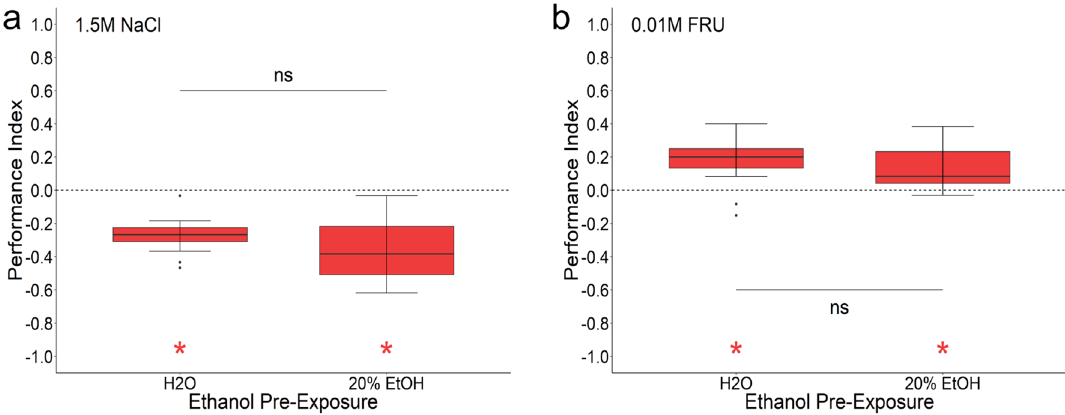
Figure 6. Pre-exposure to ethanol does not change aversive and appetitive olfactory learning. Before the larvae were conditioned, they were separated from their food and treated for 20 min with either water or 20% ethanol. They were then washed and trained with the odors AM and BA and either 1.5 M NaCl or 0.01 M fructose as a teaching signal. ( a ) Larvae treated with water and 20% ethanol both showed an aversive odor-salt memory (one- sample t test, pwater < 0.001, ppre-EtOH < 0.001) that was not different from each other (paired t-test, p < 0.112). Sample size for each box plot is n = 15. ( b ) Larvae treated with water and 20% ethanol both showed an appetitive odor-fructose memory (one-sample t test, pwater < 0.001, ppre-EtOH < 0.001) that was not different from each other (paired t-test, p < 0.484). Sample size for each box plot is n = 15. Differences against zero are indicated in red at the bottom of each panel. Significant differences of two groups are specifically indicated with an asterisk. Non-significant results are not indicated. Preference scores and statistical tests underlying the different indices are documented in the Supplementary